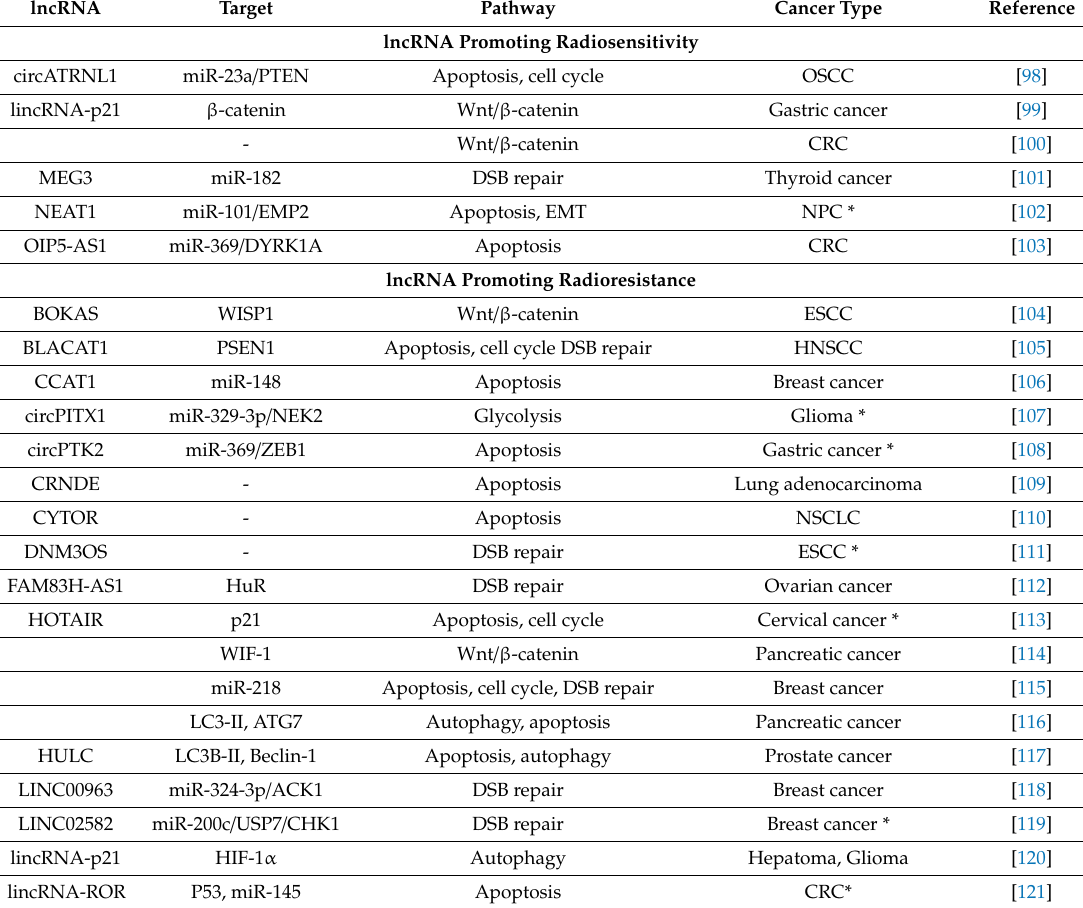
Table 2. Long non-coding RNAs (lncRNAs) promoting radiosensitivity or radioresistance in cancer cells.